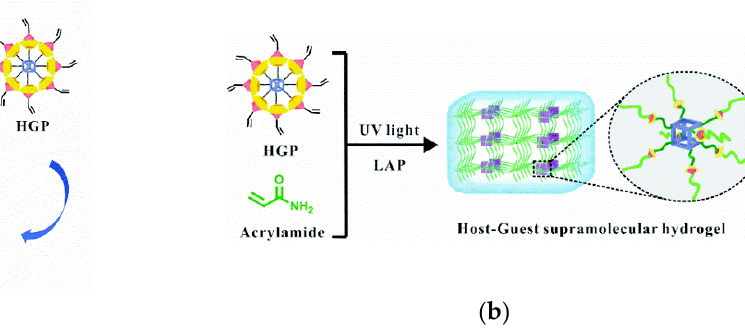
Figure 34. Structure of a POSS-based supramolecular crosslinker and formation of a hydrogel based on reversible host – guest interactions. Reproduced from Biomater. Sci. 2020, 8 , 3359 – 3369 [105], with permission from the Royal Society of Chemistry.